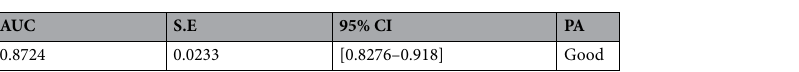
Table 2. Classification performance indices using ApEn value as the main classification feature.